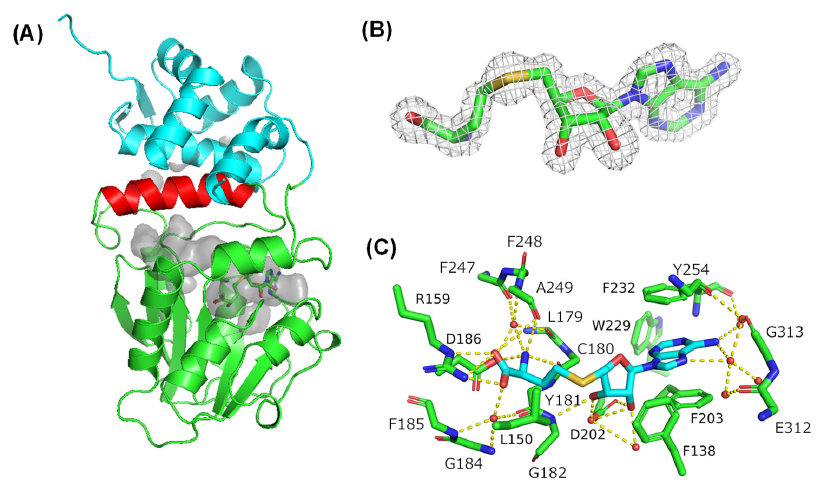
Figure 2. Crystal structure of SAM-dependent methyltransferases from the anammox bacteria (AmxMT1) Brocadia fulgida along with S -adenosyl- L -homocysteine (SAH). ( A ) Overall structure of AmxMT1. α -domain at the N-terminus, αβα sandwich core domain, and inserted α 9 are shown in cyan, green, and red, respectively. SAH is shown as a stick model. A substrate binding and active site pocket is shown in gray as a surface model. ( B ) F o − F c Polder omit electron density map for SAH contoured at 3.0 σ . ( C ) Close-up view revealing the SAH binding mode. The main chain amino acid residues and their numbers are